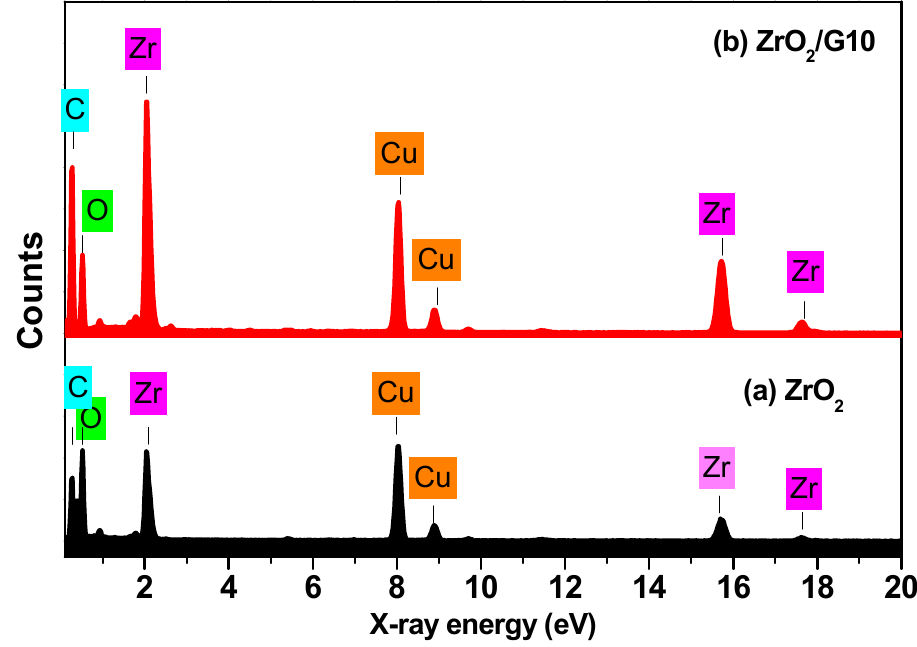
Figure 3. EDX charts for elemental analysis for: ( a ) ZrO 2 and ( b ) ZrO 2 /G10 samples. Table 1. Compositional elements of Zr, O, and C calculated from EXD spectra. ZrO Element